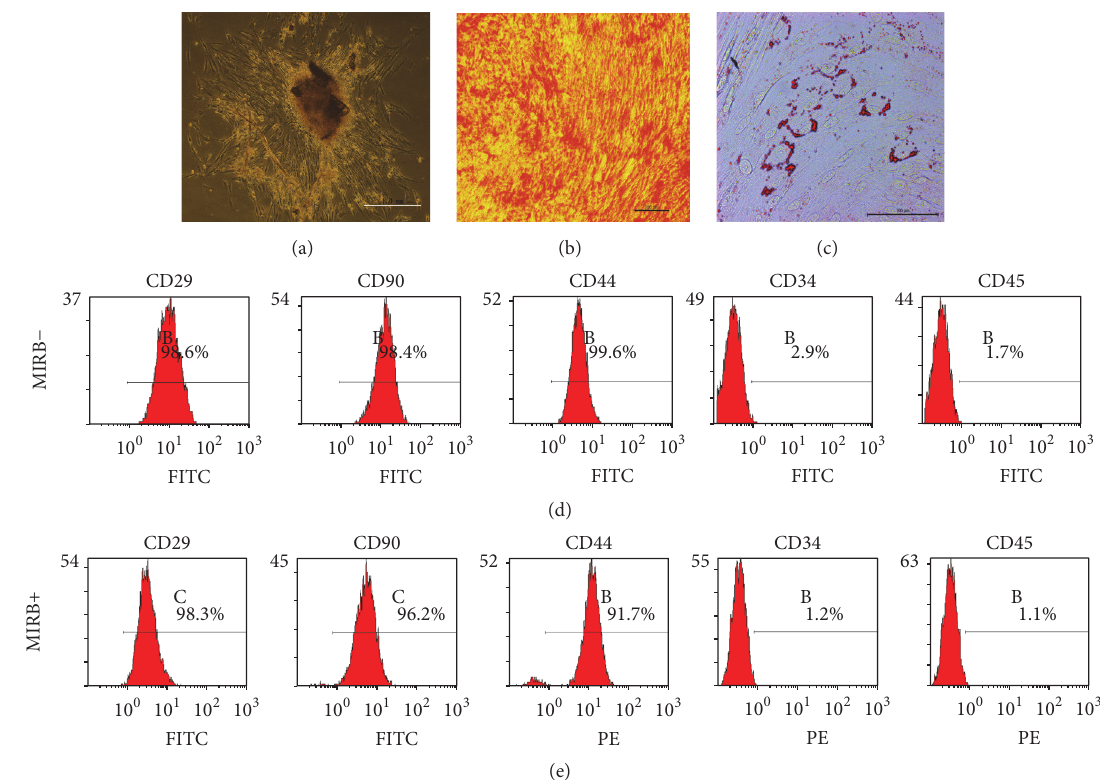
Figure 1: Isolation and characterization of human dental pulp stem cells (DPSCs). (a) The morphological observation of primary culture expanded dental pulp stem cells (DPSCs). (b) Odontogenic/osteogenic differentiation of DPSCs. (c) Adipogenic differentiation of DPSCs. (d and e) Representative flow cytometry analysis of cell surface markers in unlabeled and labeled hDPSCs. Cell surface markers (d) on unlabeled hDPSCs in P3 and (e) on MIRB-labeled hDPSCs in P3. Data show that both labeled and unlabeled hDPSCs are negative for CD34 and CD45 while they are positive for CD29, CD90, and